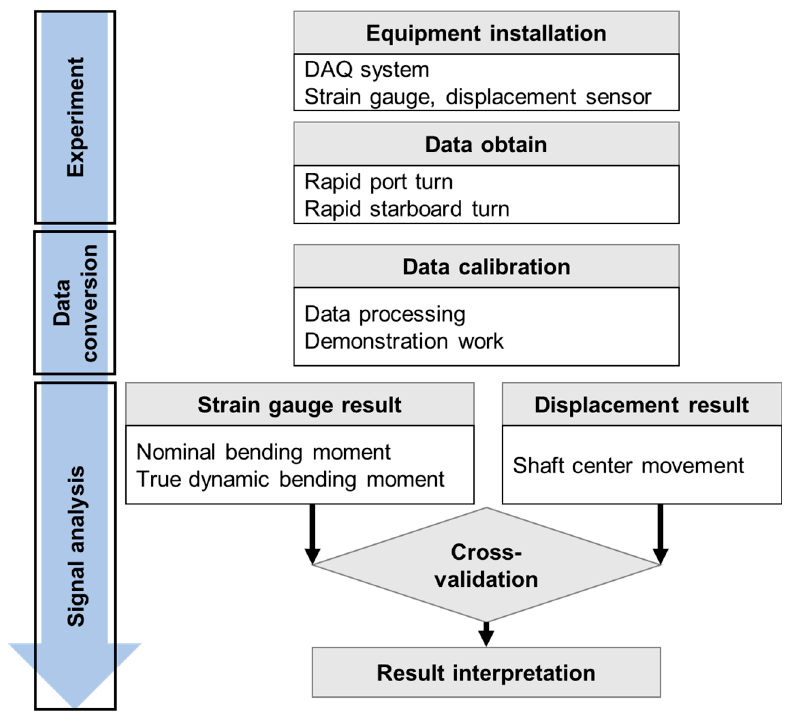
Figure 1. The flowchart of research approach.